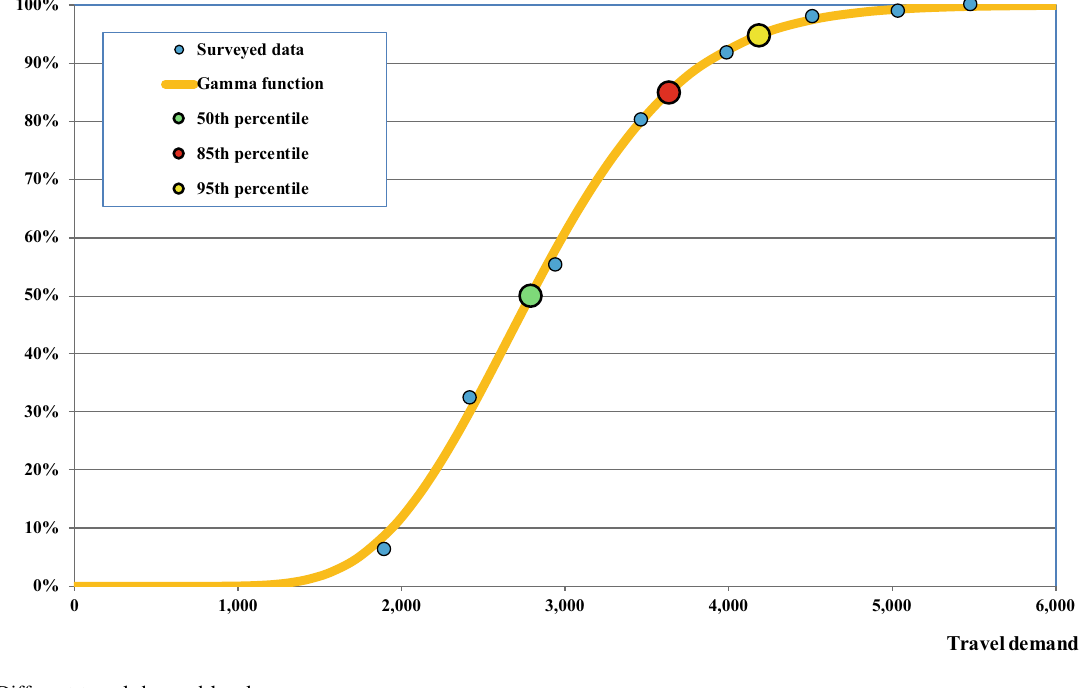
Fig. 4 Different travel demand levels Fig. 5 Dwell time calibration